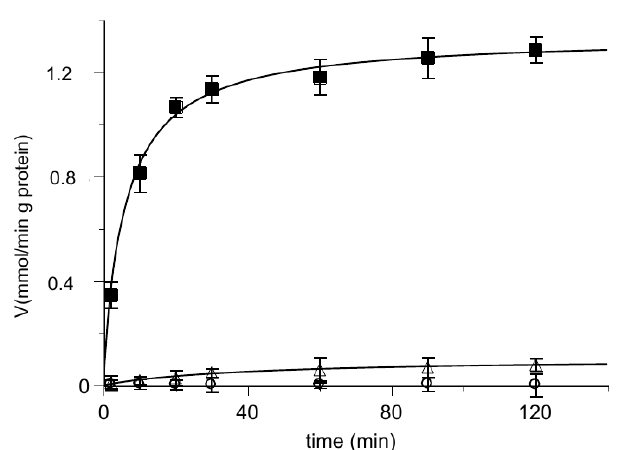
Figure 4. Time course of [ 14 C] 2-oxoglutarate uptake in reconstituted proteoliposomes. At zero time, 0.025 mM [ 14 C] 2-oxoglutarate is added to reconstituted proteoliposomes containing 6 mM of 2-oxoglutarate ( ), 50 µM hemin ( ) or 10 mM Pipes ( ). Transport was stopped by adding 10 μL of PLP 350 mM at the indicated times and the intraliposomal radioactivity was measured. The data are the means ± SD from three different experiments.